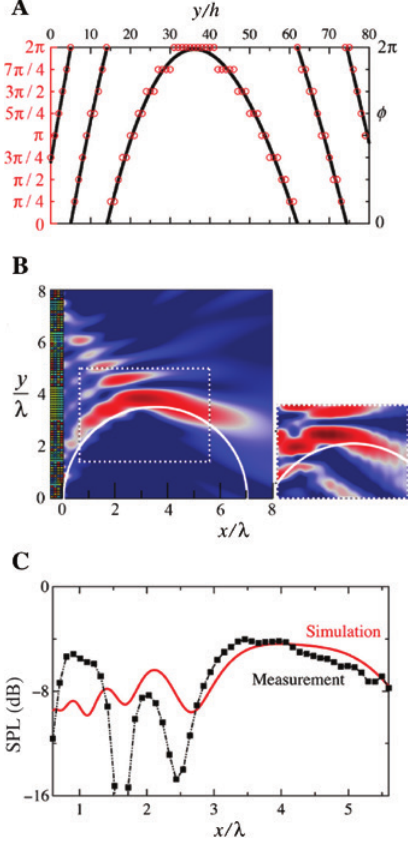
Figure 6: Production of self-bending beam based on acoustic